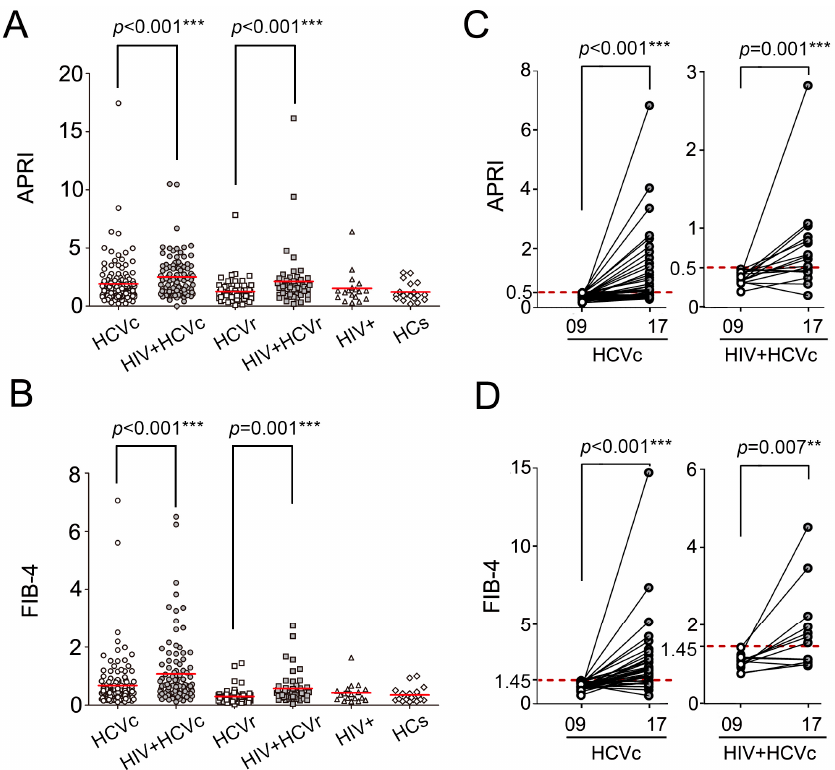
Figure 3. Comparison of APRI and FIB-4 levels and variations among different subgroups. ( A ) APRI and ( B ) FIB-4 levels in different subgroups at the first follow-up in 2009. The variation of ( C ) APRI and ( D ) FIB-4 levels from 2009 to 2017. To maintain neutrality, only individuals with normal test results in 2009 were compared for variance. The red solid line indicates the median levels. The red dashed line indicates normal values of reference. (*, p < 0.05; **, p < 0.01; ***, p < 0.001).